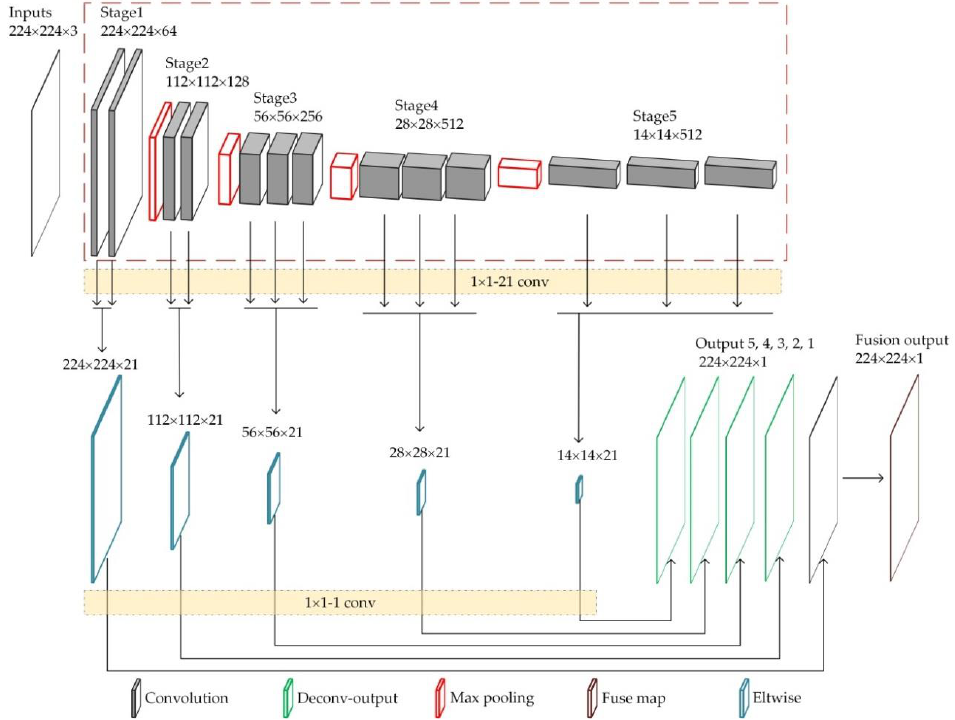
Figure 4. Overview of the RCF network architecture.